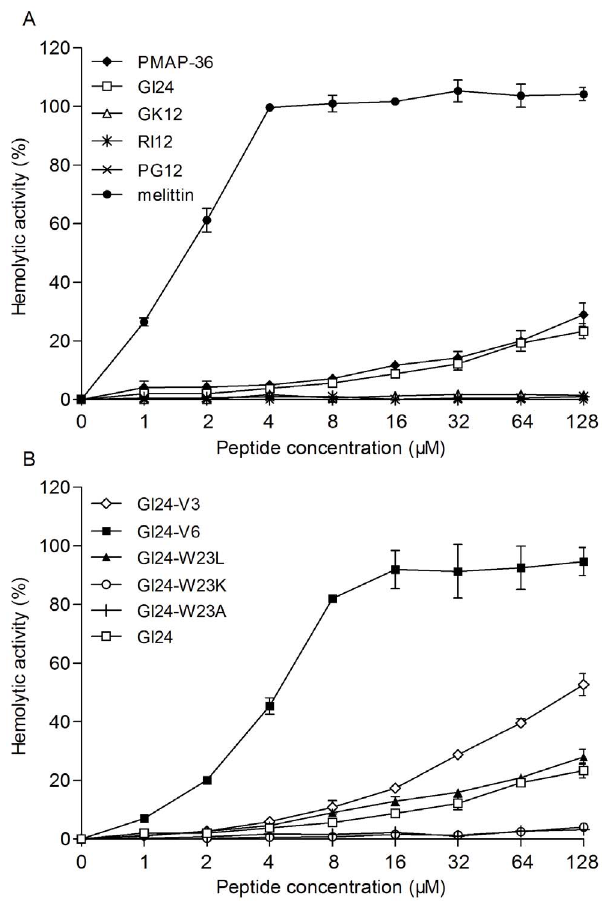
Figure 2. Hemolytic activities of the truncated peptides (A) and residue-substituted peptides (B) against fresh human erythro- cytes. The release of hemoglobin was monitored with a Microplate autoreader by measuring the absorbance at 570 nm. Data are the averages of three independent experiments.